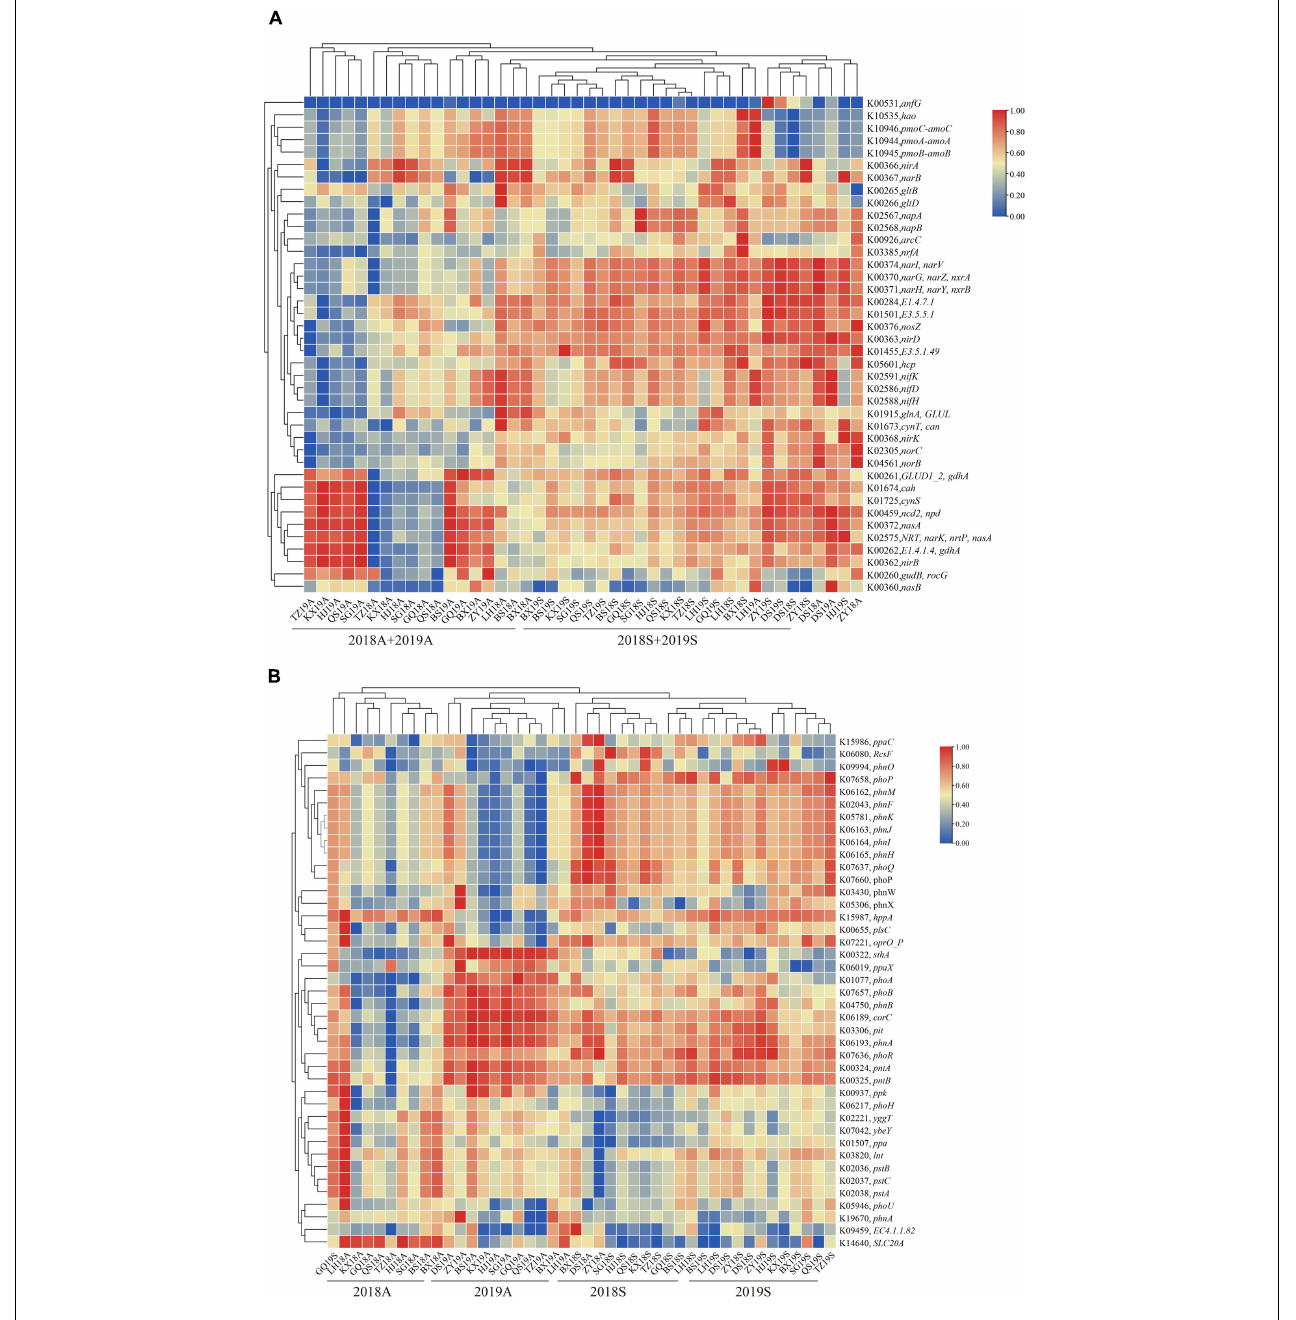
FIGURE 5 | Heatmap showing the hierarchical clustering of the predicted functional genes related to the N (A) and P (B) cycles in bacterioplankton